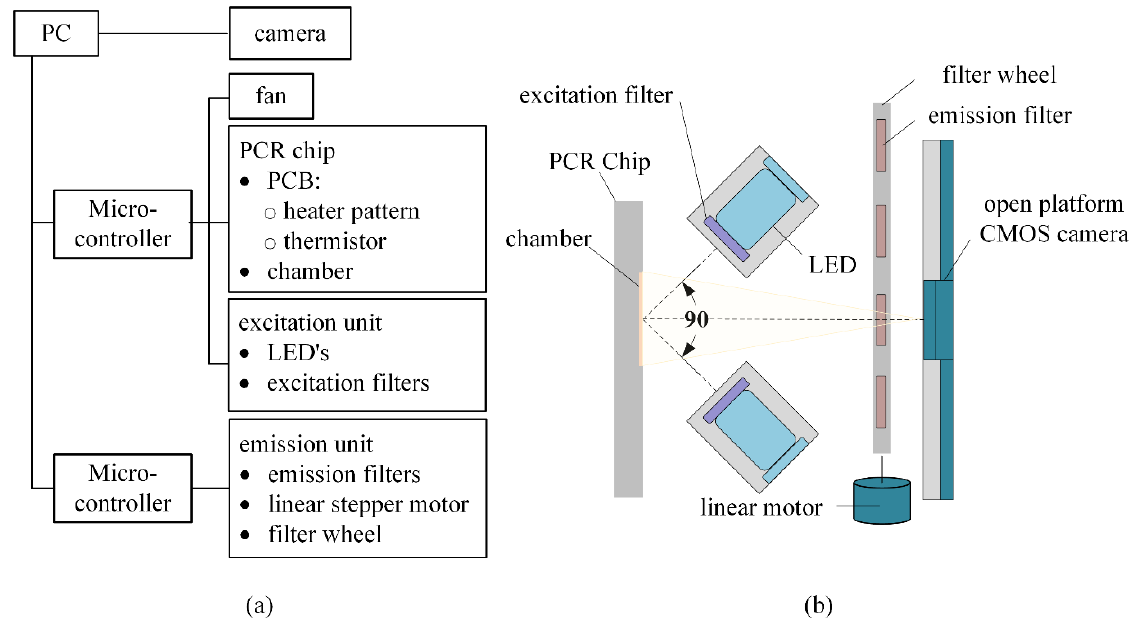
Figure 2. Functional block diagram and schematic of the proposed system. ( a ) Block diagram; ( b ) Schematic.